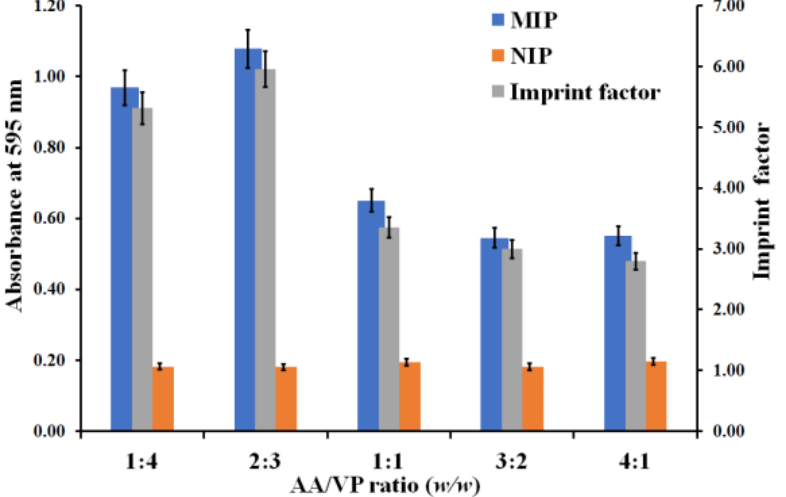
Figure 3. Absorbance of MIP and NIP obtained for varying AA/VP ratios (left-hand axis). The right-hand axis gives the respective imprint factor.